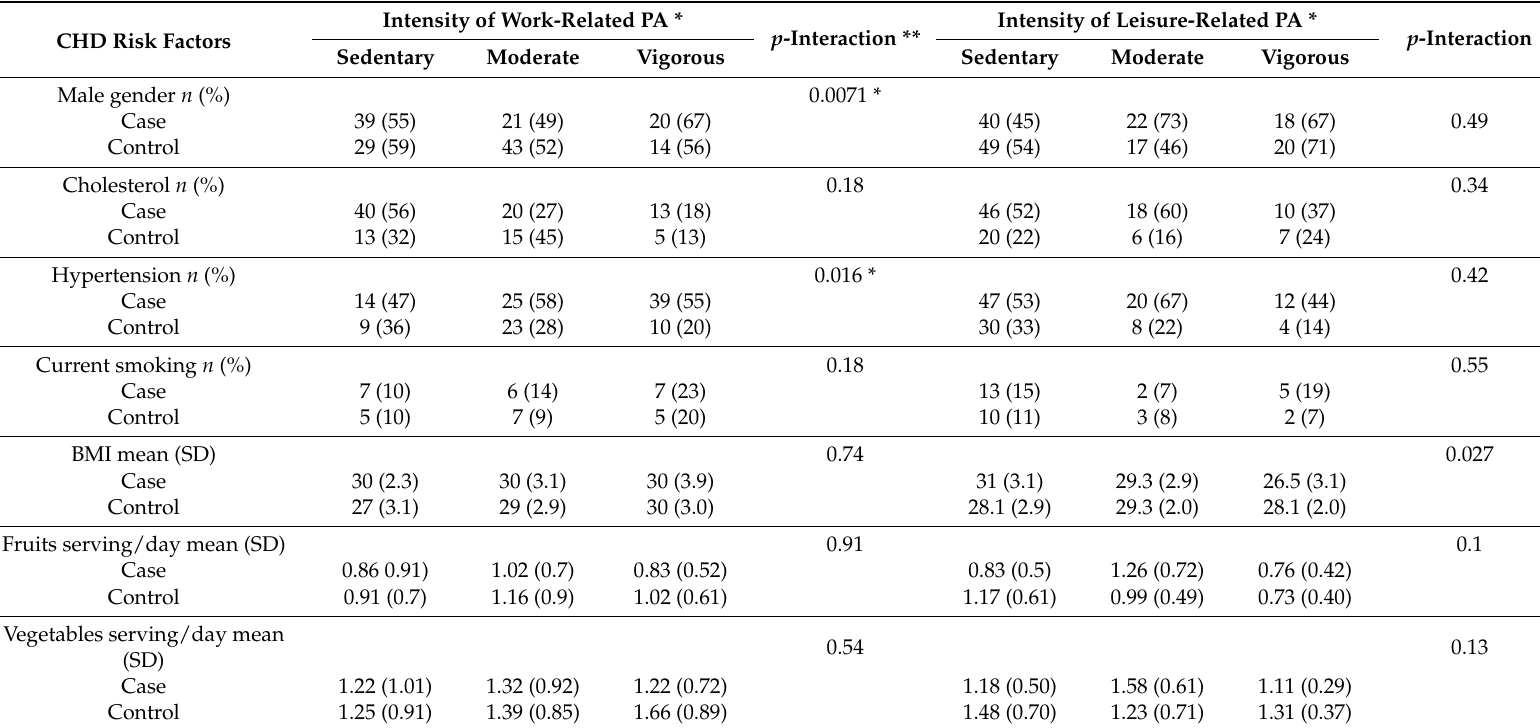
Table 3. Interactions between work- and leisure-related PA and other factors related to coronary heart disease.